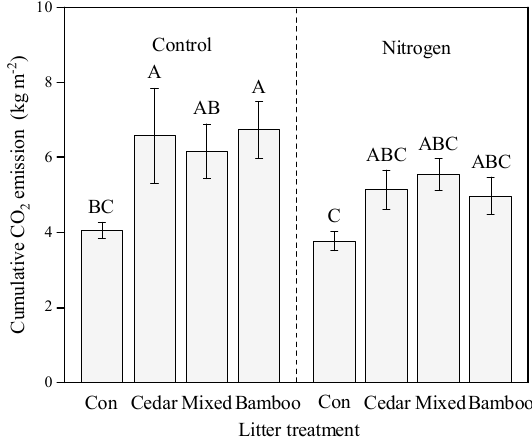
Figure 3. Cumulative soil CO 2 emissions (kg m − 2 ), as affected by nitrogen (control vs. nitrogen) and fine root litter (con, cedar, bamboo, or mixed litter by cedar and bamboo fine root) treatments.